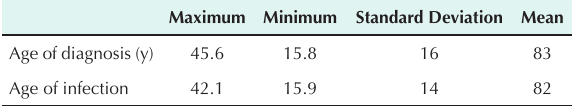
Table 1. Age of Infection and Diagnosis of Patients With MG